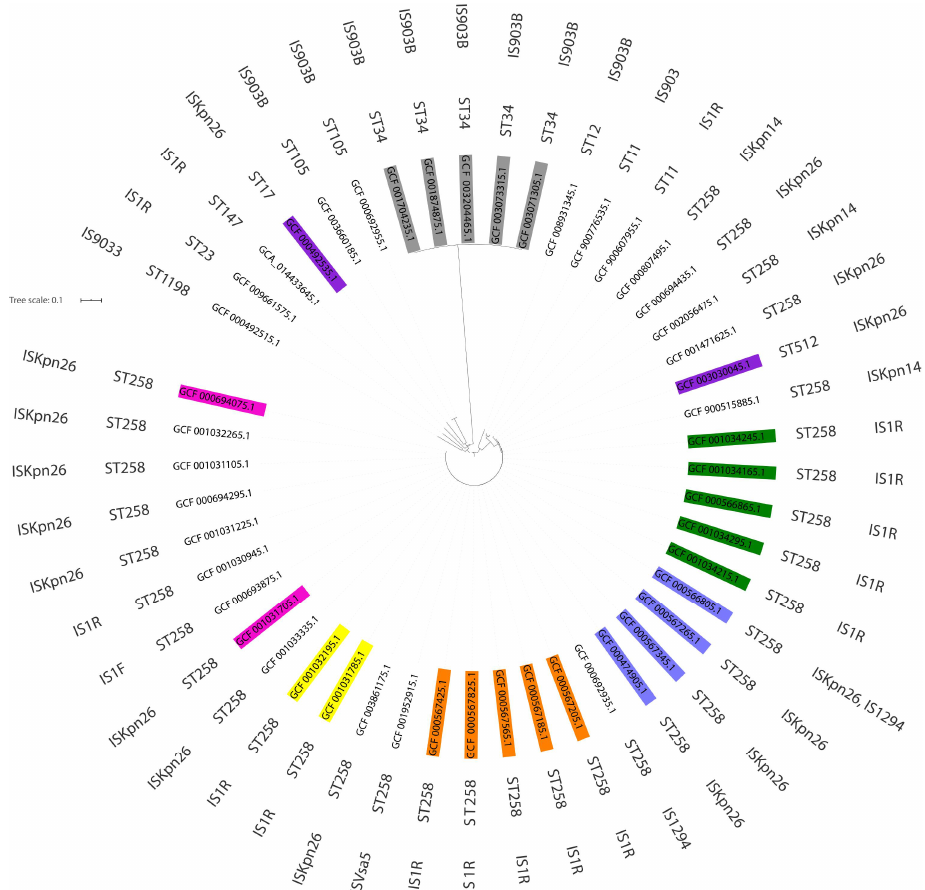
Figure 3. Results of clonality (MLST) and phylogenetic analyses of O2v2 K. pneumoniae genomes characterized by ST and insertion sequences distribution. Each color indicates closely related strains characterized by genetic similarity, shown in detail in Supplementary Material Table S2. Separately analyzed isolates are not